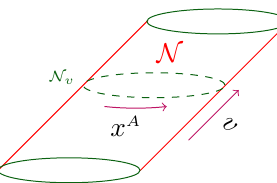
Figure 2 . Depiction of co-dimension one null boundary N . N has the topology of R v n N v where the transverse surface N v is typically a D − 2 dimensional spacelike compact